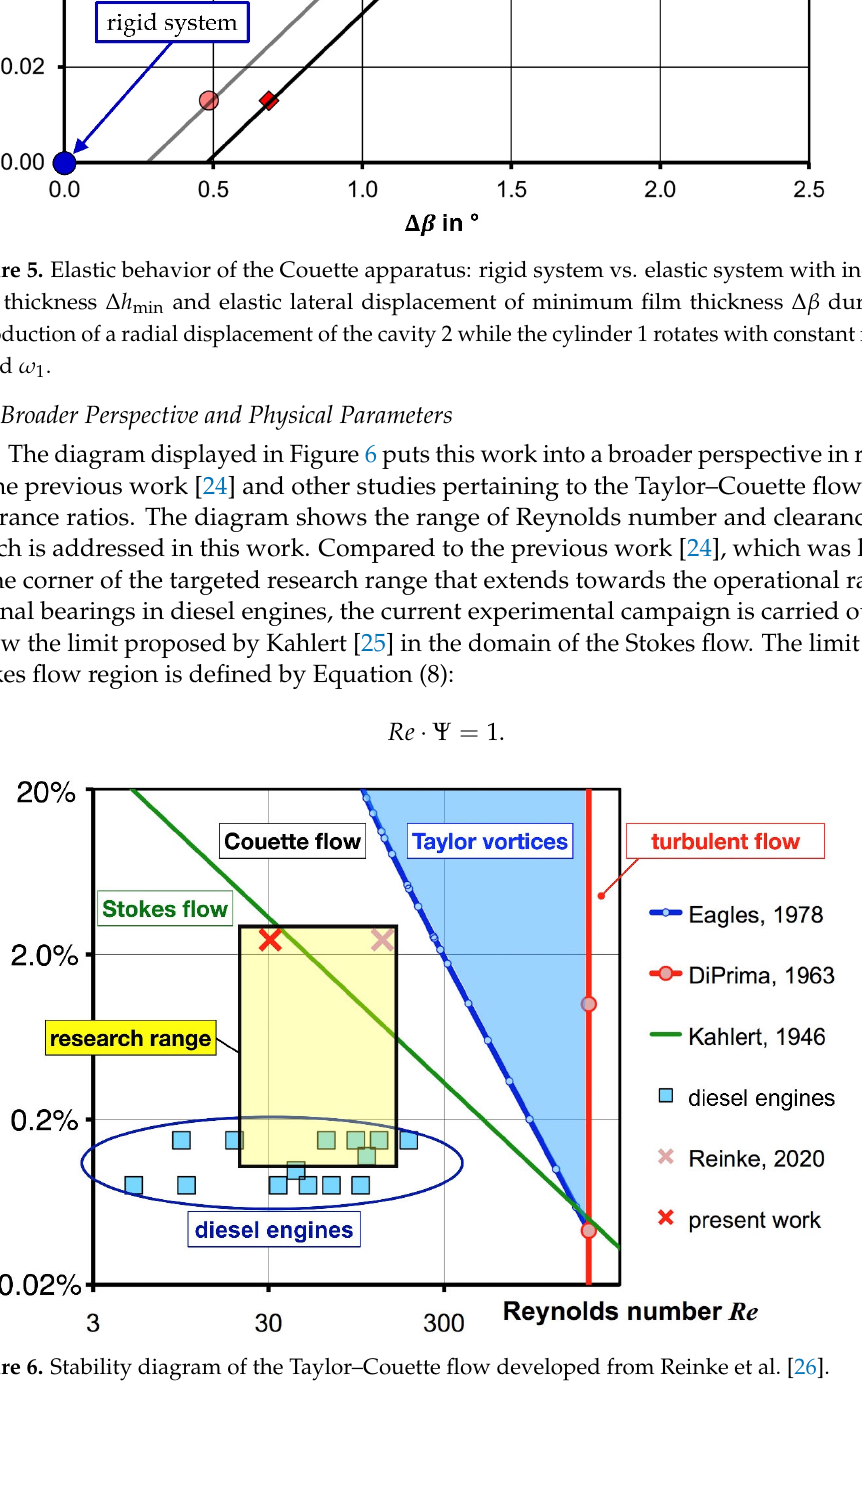
Table 2. Physical parameters of the experiment. Symbol